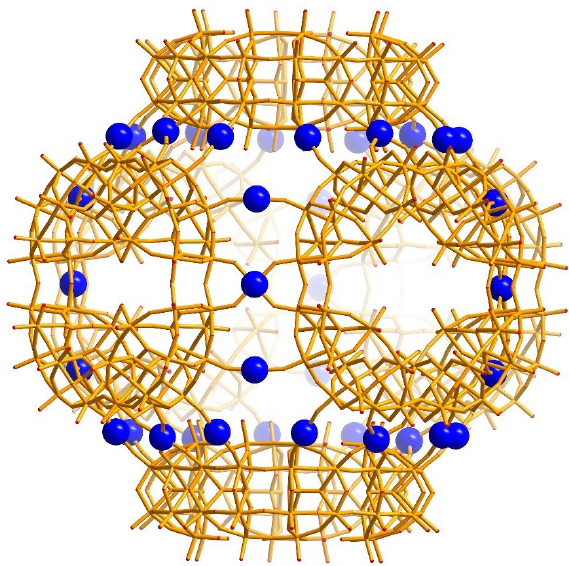
Figure 10. Representation of Mn-linked cubic framework, K 18 Li 6 [Mn 8 (H 2 O) 48 P 8 W 48 O 184 ]∙108H 2 O. The {P 8 W 48 } units are connected through Mn II centres to form a face-directed cube, with internal cavity volume of ca. 7.2 nm 3 . The repeated cubic units form an infinite 3D lattice. (Colour scheme: {P 8 W 48 }, orange wired representation; Mn II , blue spheres).